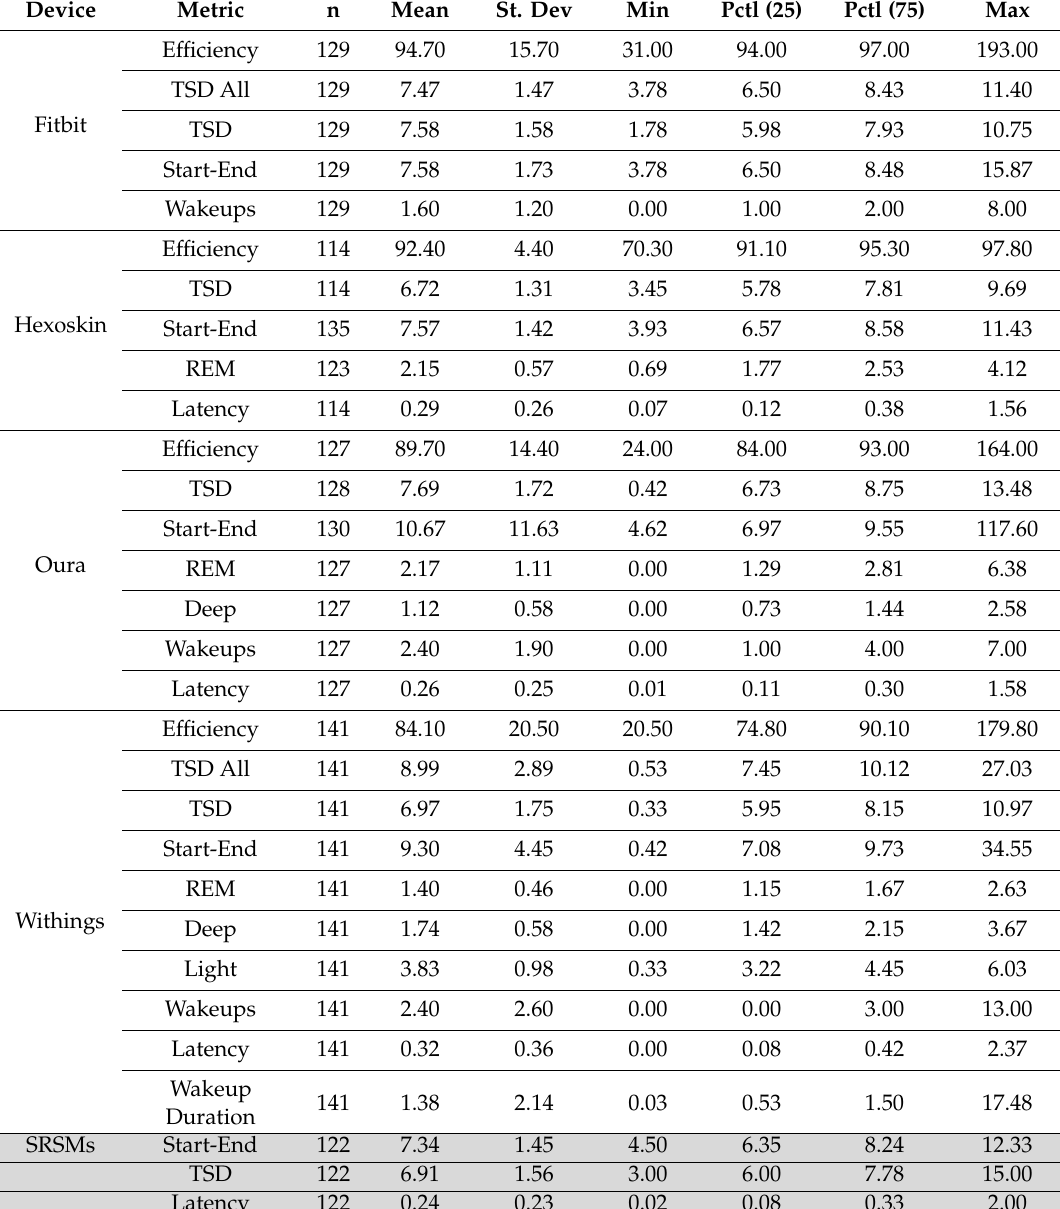
Table 2. Summary metrics of device data and SRSMs. All units are in hours except wakeups which is in occurrences and e ffi ciency (no units). Sleep e ffi ciency is a metric to track percentage of time in bed while asleep. TSD is total sleep duration which is similar to start-end duration and similar features were utilized that included latency and other